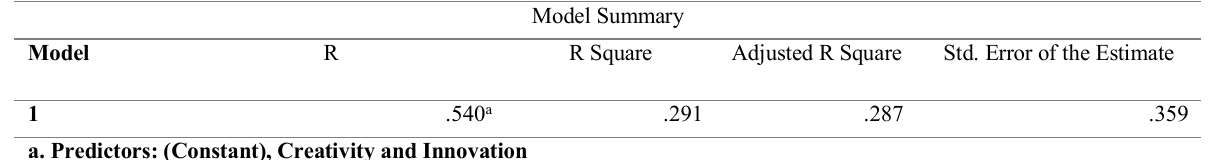
Table 2 (a): Model Summary for Creativity and Innovation and Employee Engagement